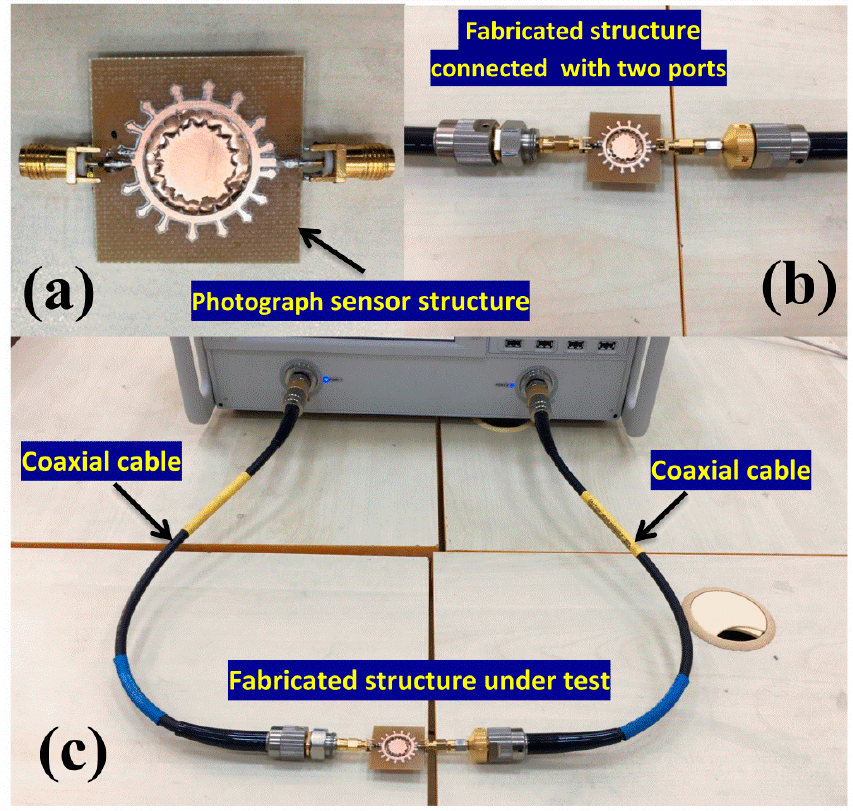
Figure 10. Photographs of ( a ) the proposed structure, ( b ) its two-port connection and ( c ) experimental setup.